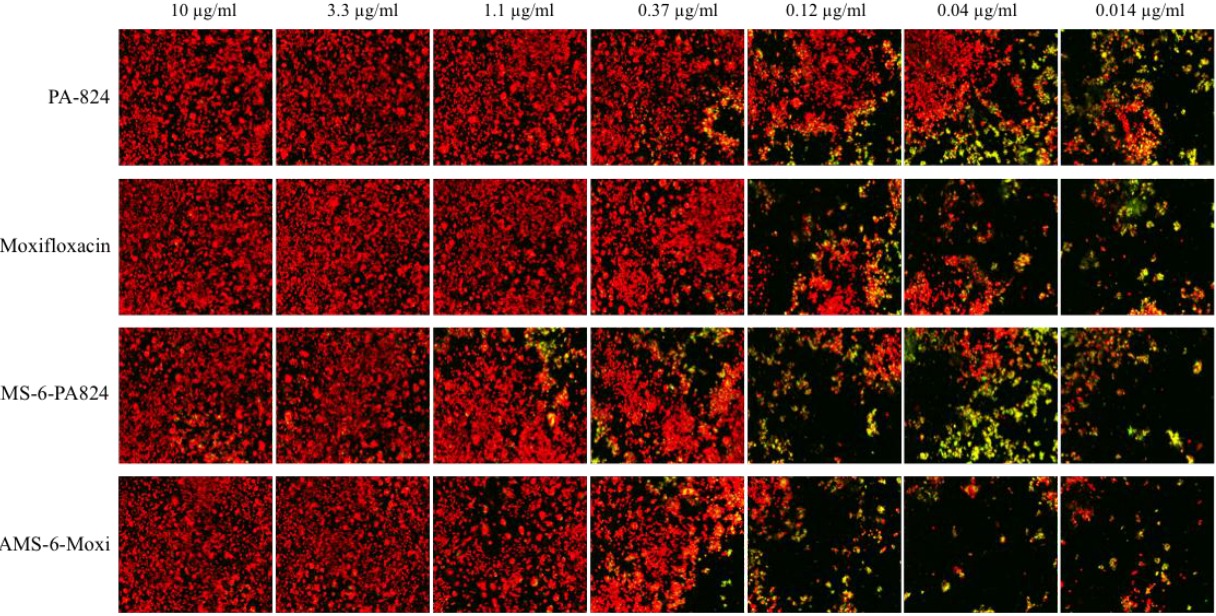
Figure 5. Confocal microscopy images of intracellular growth of tubercle bacilli inside macrophages under the treatment of PA-824, moxifloxacin, encapsulated PA-824, and encapsulate moxifloxacin at different drug concentration. Green-bacteria with green fluorescence; Red-alive